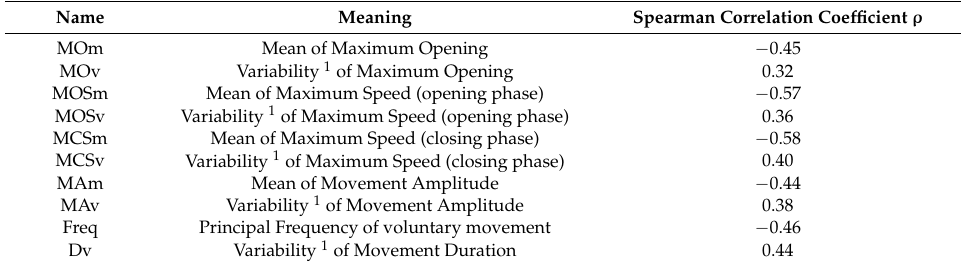
Table 3. List of significant parameters for Finger Tapping task.